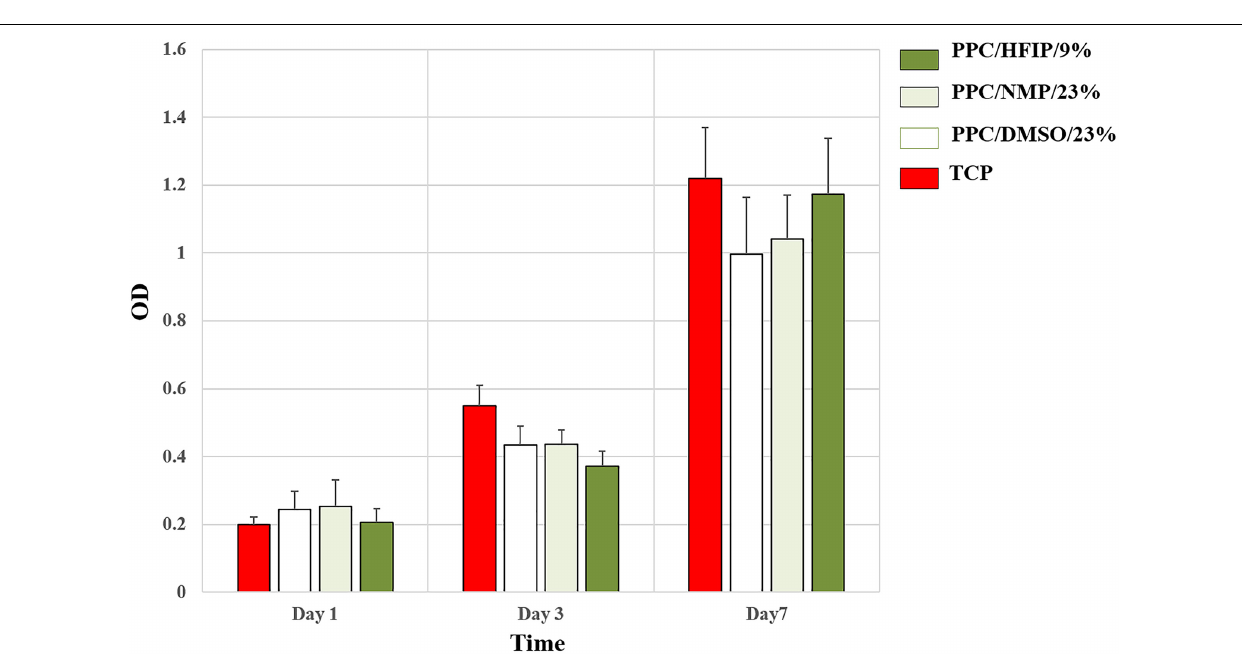
FIGURE 7 | MTT cell proliferation assay of 3T3 cells on scaffolds and TCP during the 7-day culture period. Data are expressed as mean ± SD. The difference between quantities is not significant ( p >